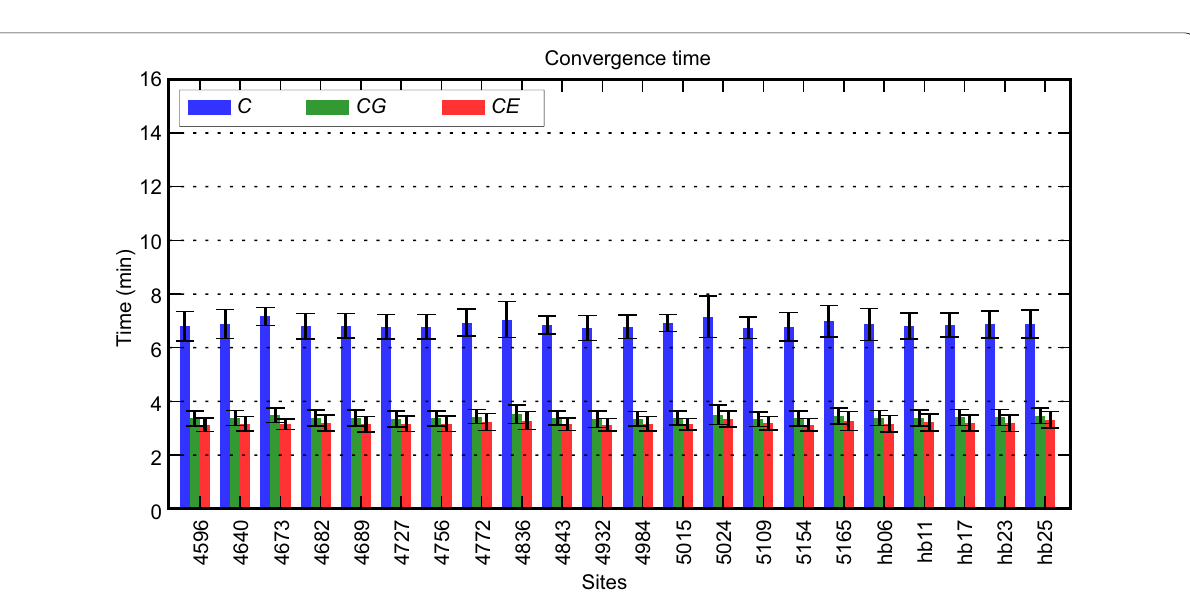
Fig. 13 Average convergence time and its variability of BeiDou only (blue), BeiDou/GPS (green), BeiDou/Galileo (red)